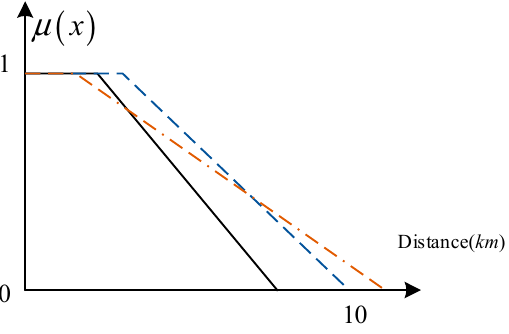
Figure 1. Different fuzzy sets for the qualitative distance word “near” perceived by different people.